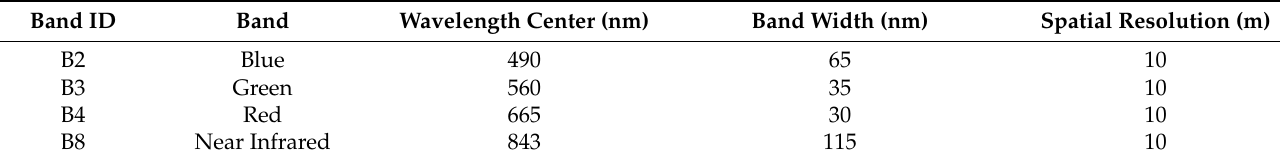
Table 2. Features of the Sentinel-2 images used in this